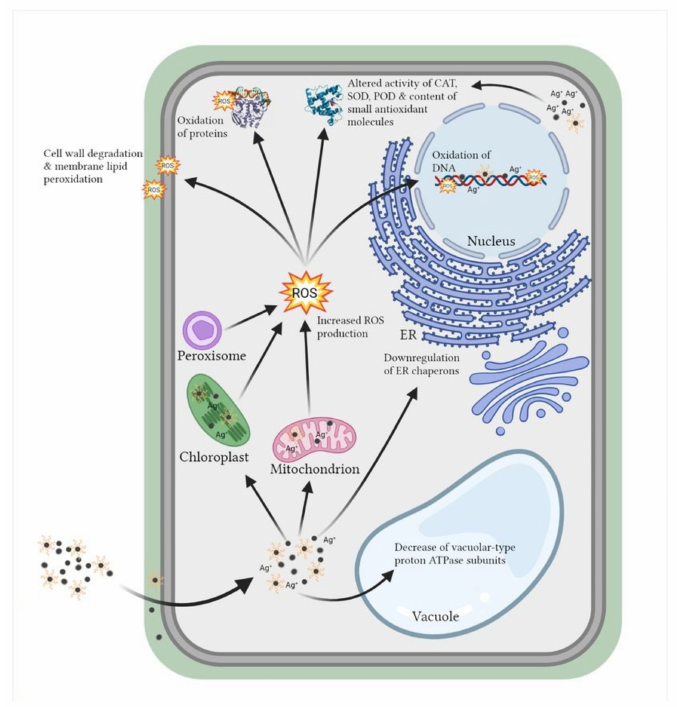
Figure 3. Effect of differently coated AgNPs on plant and algal cells by direct interaction or through ROS formation. ROS—reactive oxygen species, ER—endoplasmic reticulum, CAT—catalase, SOD— superoxide dismutase, POD—peroxidase. Adapted from “Structural Overview of a Plant Cell” by BioRender.com (2021). Retrieved from https://app.biorender.com/biorender-templates. Accessed on 17 December